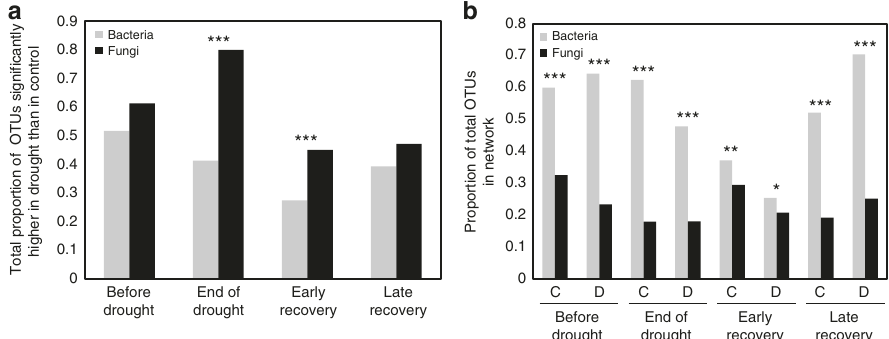
Fig. 2 Relative abundance and proportion of total bacterial and fungal OTUs included in co-occurrence networks. A signi fi cantly larger proportion of fungal OTUs than bacterial OTUs increased under drought at the end of the drought and early recovery ( a χ 2 = 122, df = 1, P < 0.001 and χ 2 = 23.2, df = 1, P < 0.001, respectively). A signi fi cantly larger proportion of bacterial OTUs was included in bacterial co-occurrence networks than of fungal OTUs in fungal co-occurrence networks ( b χ 2 -tests for all drought (D) and control (C) treatments over time were signi fi cant). Asterisks indicate the signi fi cance of the difference between proportions in bacterial and fungal communities (* P < 0.05, ** P < 0.01, *** P < 0.001)